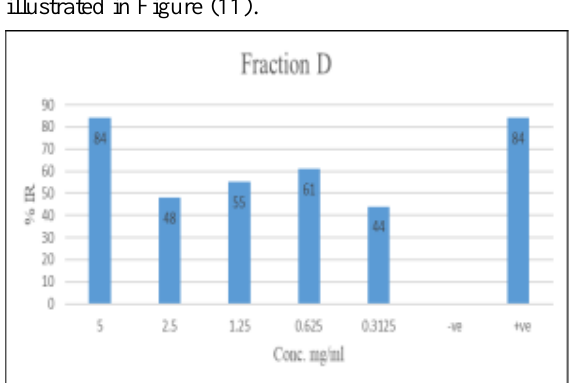
Figure 11. %IR for aerial hot n-butanol fraction (D) dilutions (S\G\n-b)